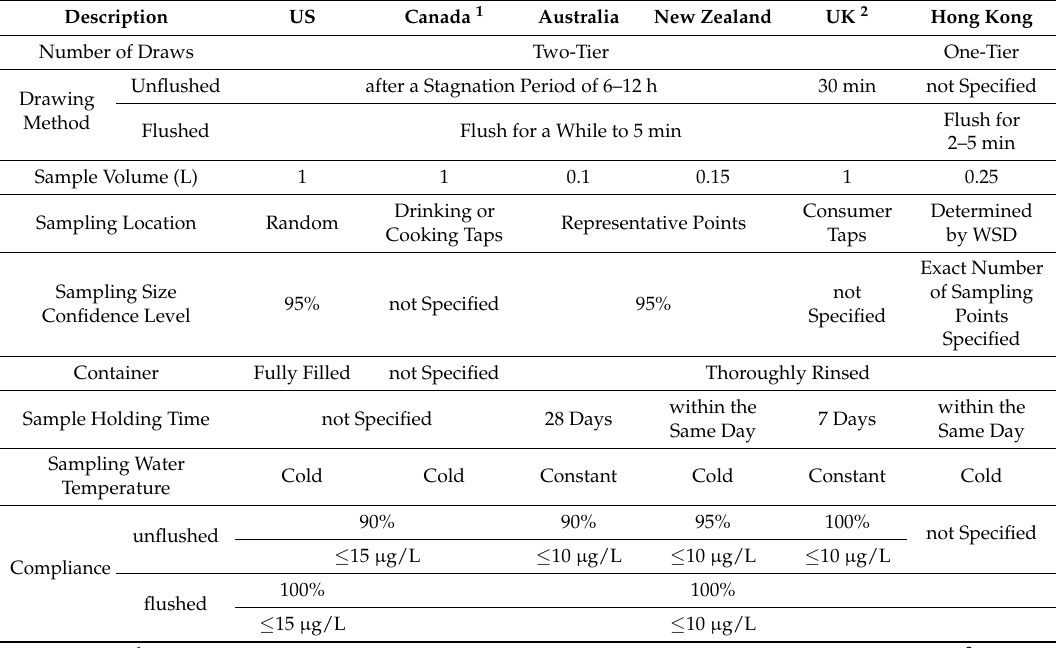
Table 4. Sampling protocols for copper pipelines of different